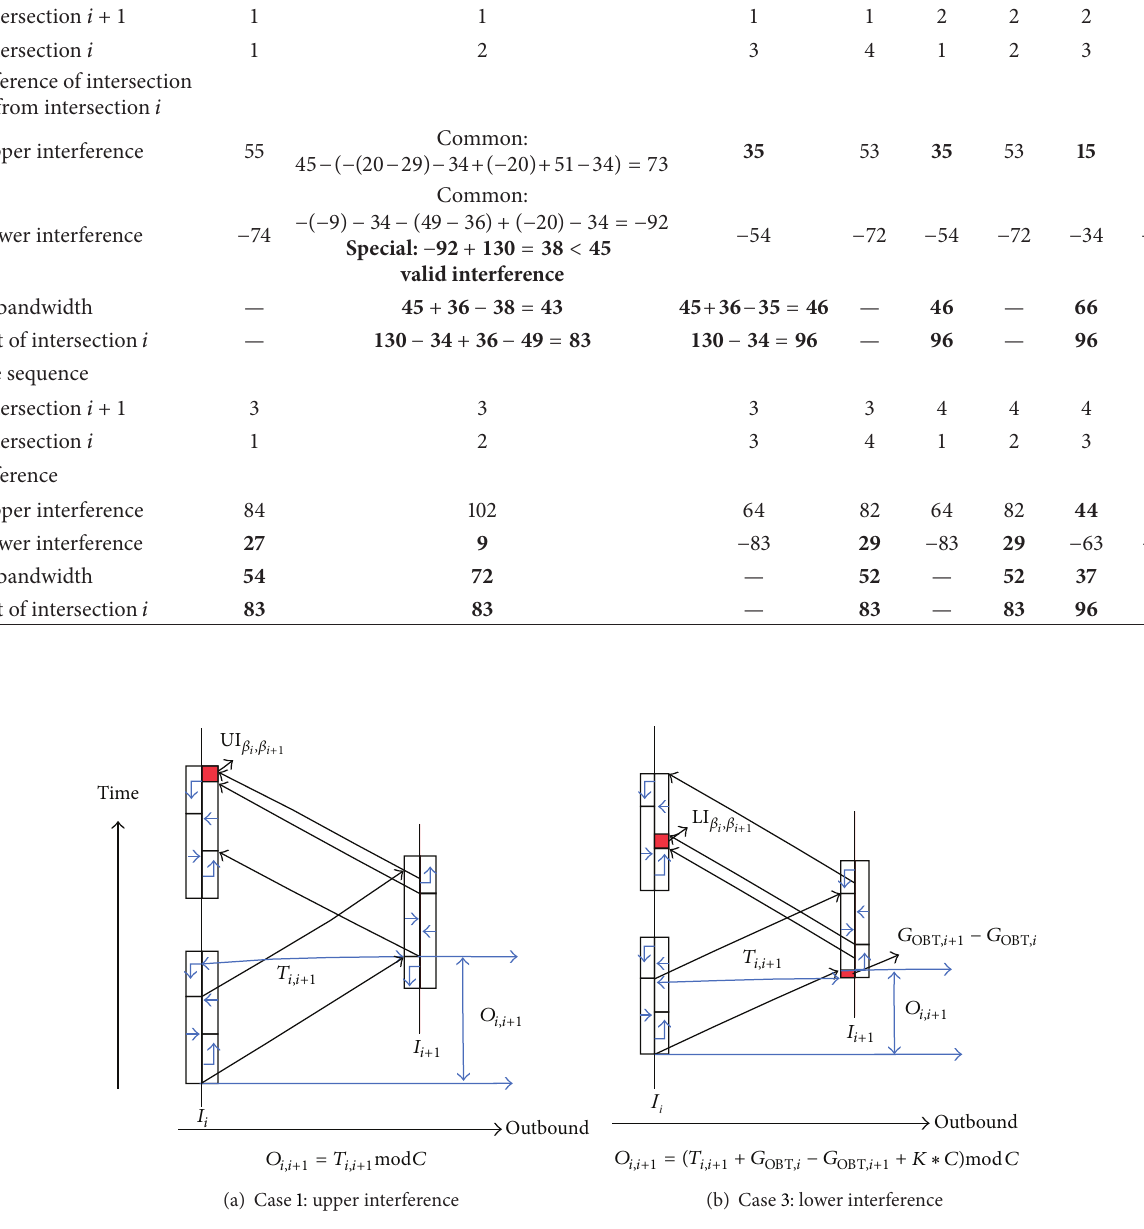
Figure 4: The calculation of relative